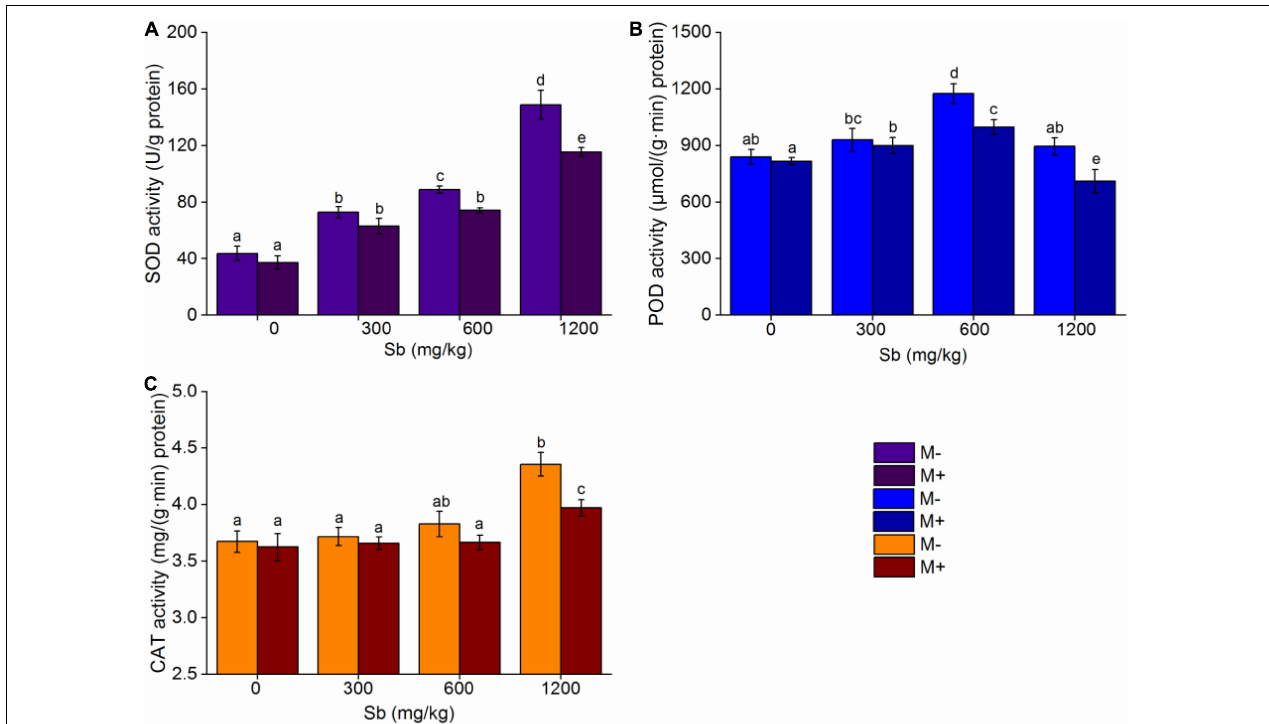
FIGURE 7 | Effects of AMF on antioxidant enzymes of rice. (A) SOD, (B) POD, (C) CAT. Error bar was calculated from three parallel samples. Error bars sharing no common letter indicate that SOD, CAT, and POD activity are significantly different at P < 0.05 level for treatments. The data are means ± SDs ( n =